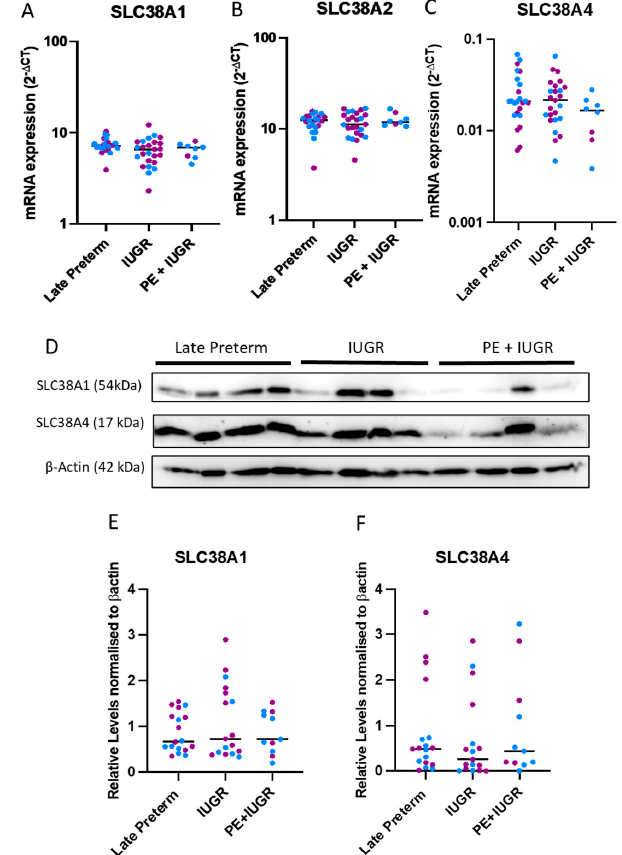
Figure 2. In late gestation patients, the expression of transporters were indifferent between IUGR complicated placentas and preterm controls. The mRNA levels (assessed via qPCR) of the trans- porters ( A – C ) and protein levels (assessed via Western blots) ( D ) when quantified ( E , F ) did not reveal changes to the expression of system A amino acid transporters. (n = 8–25 samples/cohort). Results are displayed as medians (Kruskal Wallis non-parametric test). Blue dots (male pregnancies), purple dots (female pregnancies).